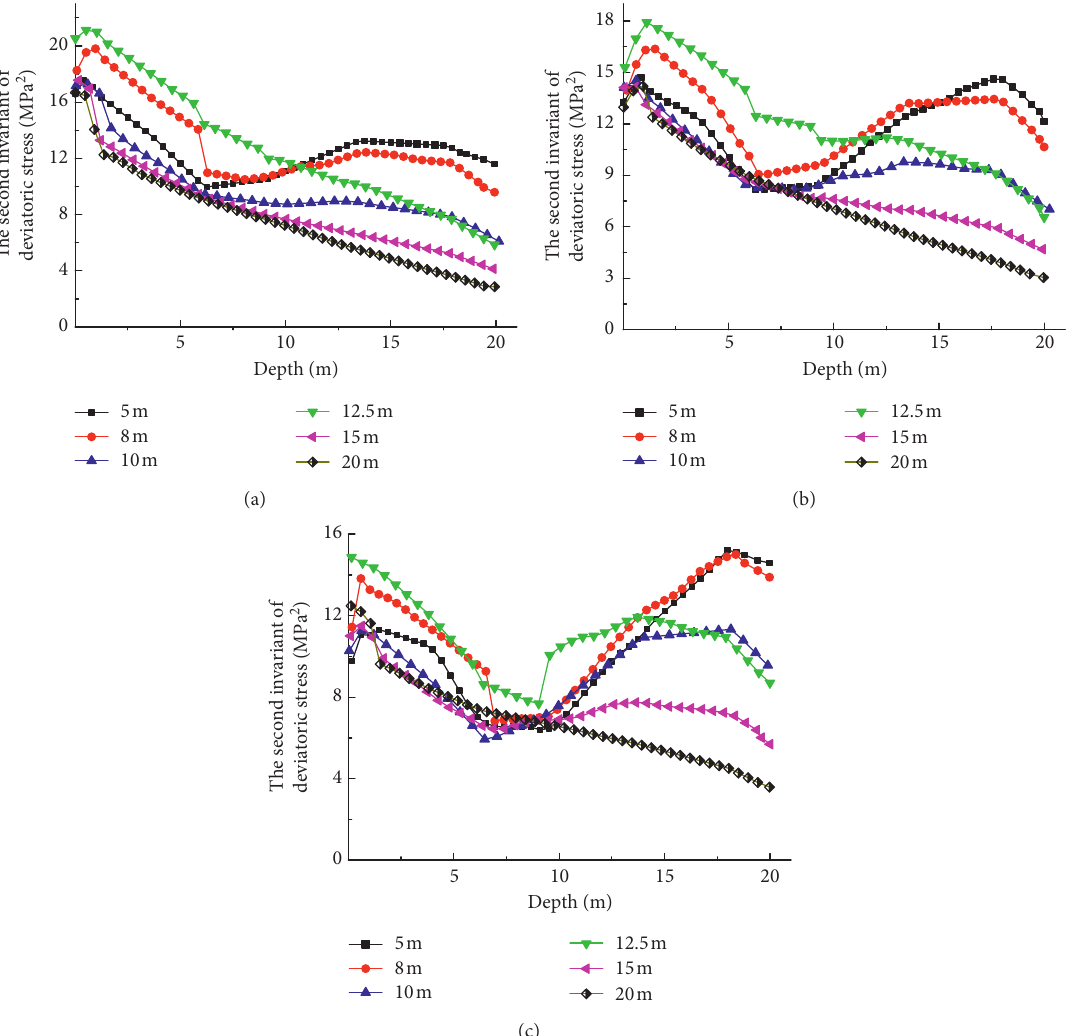
Figure 8: The second invariant of deviatoric stress curve by top slab surrounding rock monitoring line. (a) 1 # monitoring line. (b) 2 # monitoring line. (c) 3 # monitoring